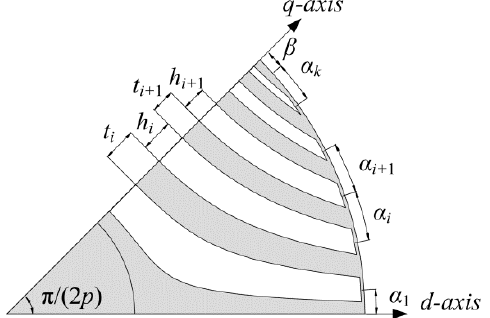
Figure 1. Rotor structure and design variables of the initial motor.